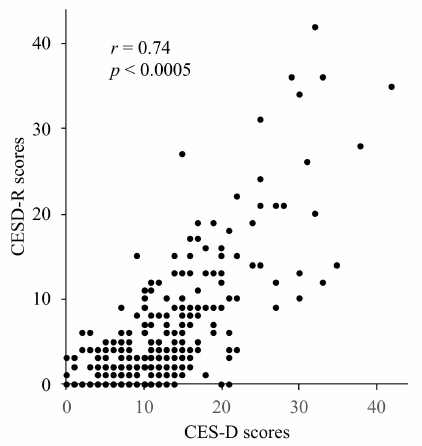
Figure 2. Correlations between CES-D and CESD-R scores. The total scores of CESD-R were significantly positively correlated with those of CES-D after controlling for age and BMI ( r = 0.74, p < 0.0005). BMI: body mass